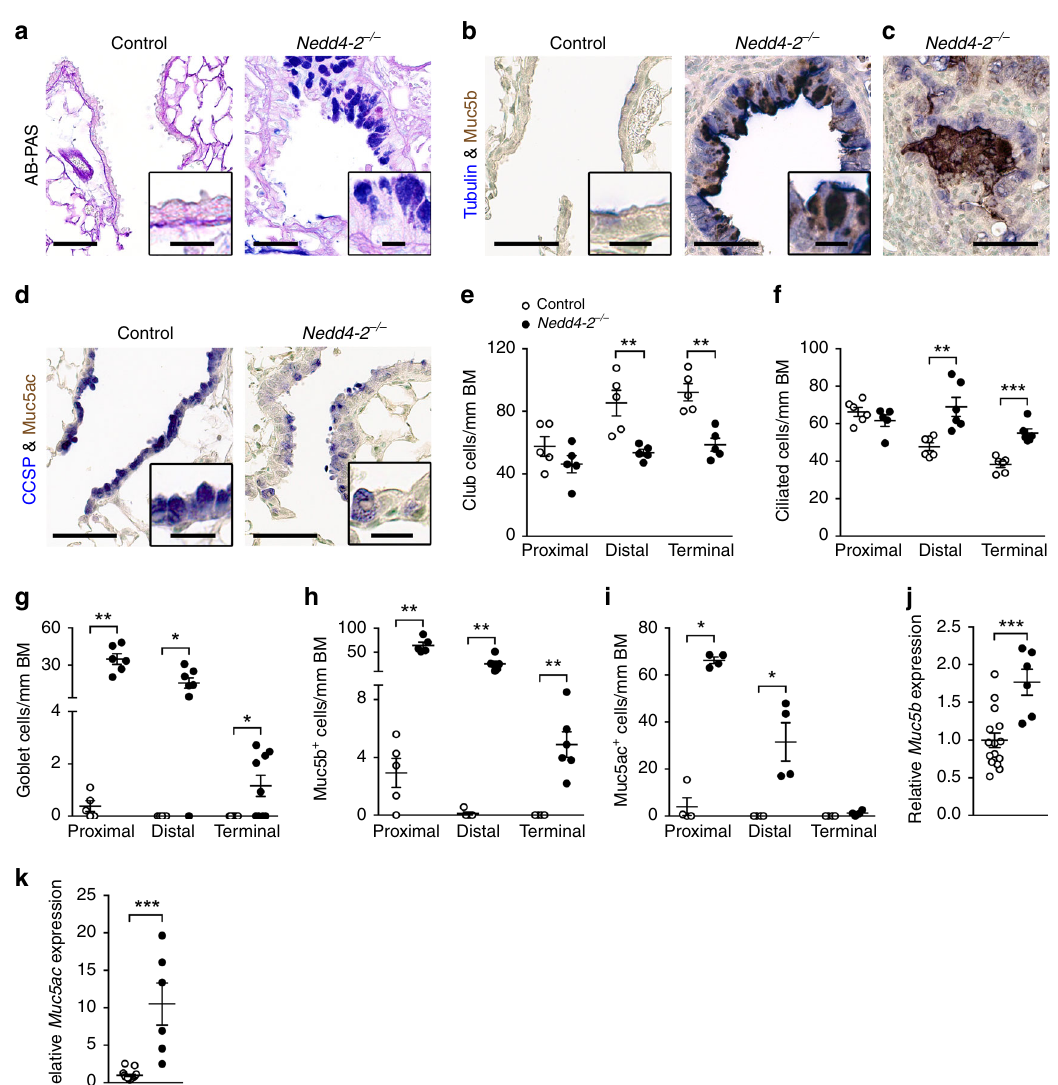
Fig. 3 Conditional deletion of Nedd4-2 in lung epithelial cells causes peripheral airway remodeling with increased Muc5b production. a – d Representative micrographs and high magni fi cation insets illustrating the airway cell population of terminal bronchioles from conditional Nedd4-2 − / − mice and littermate controls after 3 months of doxycycline induction stained with Alcian blue and periodic acid-Schiff (AB-PAS) (control, n = 5 mice; Nedd4-2 − / − , n = 9 mice) ( a ), or co-stained with anti-Muc5b and anti-acetylated α -tubulin antibodies (control, n = 5 mice; Nedd4-2 − / − , n = 6) ( b , c ), or with anti-Muc5ac and anti-CCSP antibodies ( n = 4/group) ( d ). Scale bars, 60 and 15 µ m (insets). e – i Summary of numeric densities of club cells ( n = 5 mice/group) ( e ), ciliated cells ( n = 6/group and proximal, conditional Nedd4-2 − / − , n = 5 mice) ( f ), goblet cells (proximal, control, n = 5 mice; conditional Nedd4-2 − / − , n = 6 mice; distal, control, n = 5 mice; conditional Nedd4-2 − / − , n = 7 mice, terminal, n = 9/group) ( g ), Muc5b expressing cells (proximal, n = 5/group; distal, control, n = 5 mice; conditional Nedd4-2 − / − , n = 6 mice, terminal, n = 6/group) ( h ), and Muc5ac expressing cells ( n = 4/group) ( i ) in proximal, distal and terminal conducting airways of conditional Nedd4-2 − / − mice and littermate controls after 3 months of doxycycline induction (BM basement membrane). j , k mRNA expression levels of Muc5b ( j ) and Muc5ac (control, n = 15 mice; conditional Nedd4-2 − / − , n = 6 mice) ( k ) in whole lungs from 3-month induced conditional Nedd4-2 − / − and control mice. * P < 0.05, ** P < 0.01, *** P < 0.001. Statistical analysis in e , g , h , i , k was performed with two-ta i led Mann – Whitney test, and in f , and j with unpaired two-tailed t test. Data are shown as mean ± S.E.M. Source data are provided in the Source Data fi